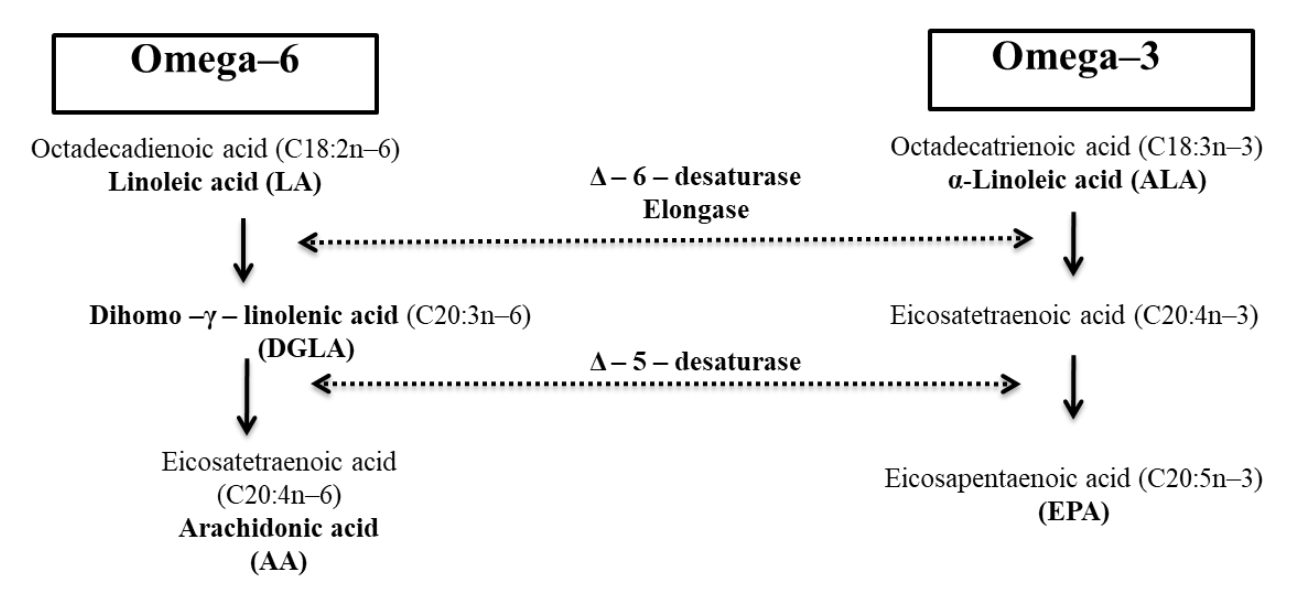
Figure 1. Simplified scheme of essential fatty acid metabolism.